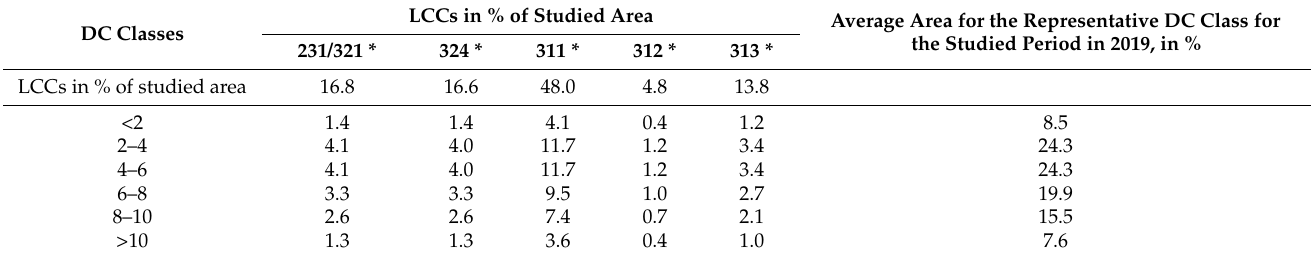
Table 4. Distribution of the drought coefficient (DC) classes within the land cover classes (LCCs) in the studied area. DC Classes